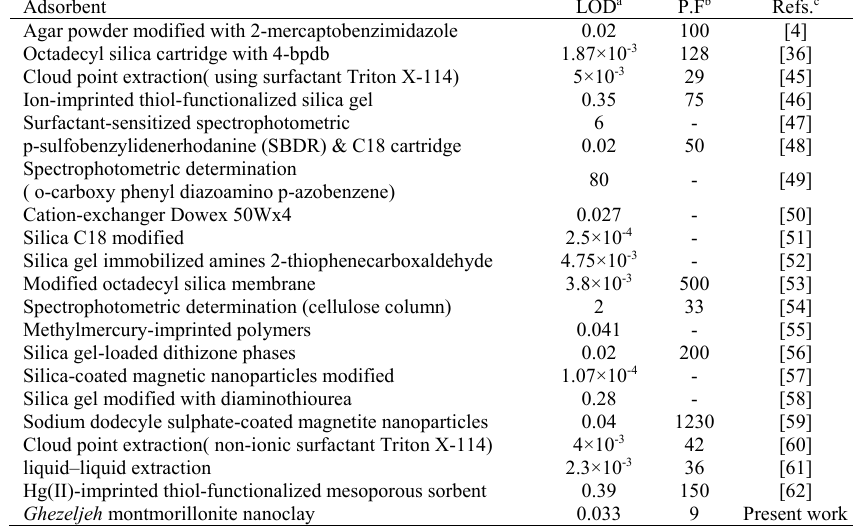
Table 3 The evaluation between the process used in this research and similar studies using some of the extraction procedures Adsorbent LOD a P.F b